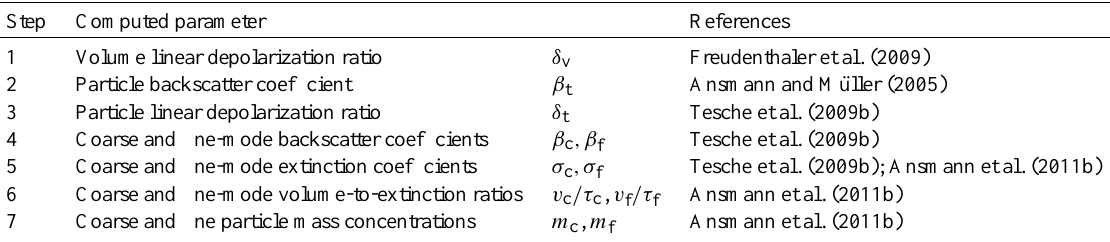
Table 1. The seven steps of the PMAP-POLIPHON retrieval scheme to obtain profiles of coarse and fine particle mass concentrations from polarization lidar observations (with support from sun-sky photometry, step 6). Indices v, t, c, and f denote volume (molecules plus particles), total (fine plus coarse mode), coarse mode, and fine mode, respectively. The methods applied in the different steps are described in the respective